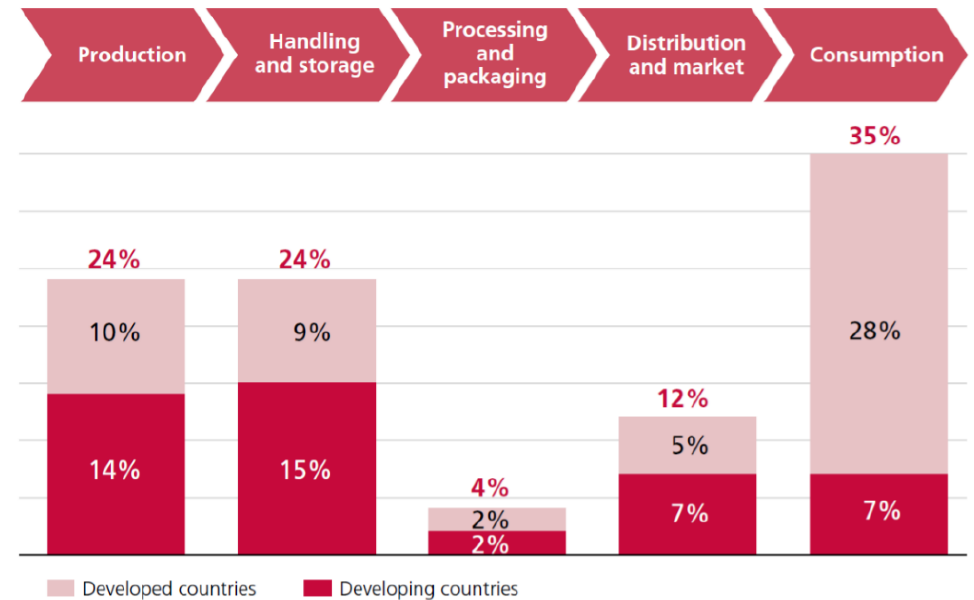
Figure 1. Stats of food loss in food supply chains (source: Gender and Food Loss in Sustainable Food Value Chains of Food and Agriculture Organizations [10]).